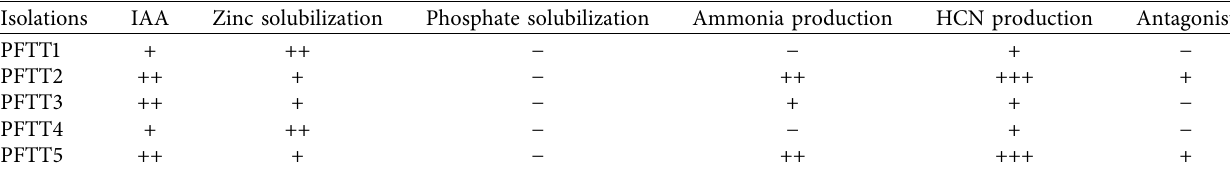
Table 2: Plant growth promoting activities of Pseudomonas fluorescens and Abelmoschus esculentus . Isolations